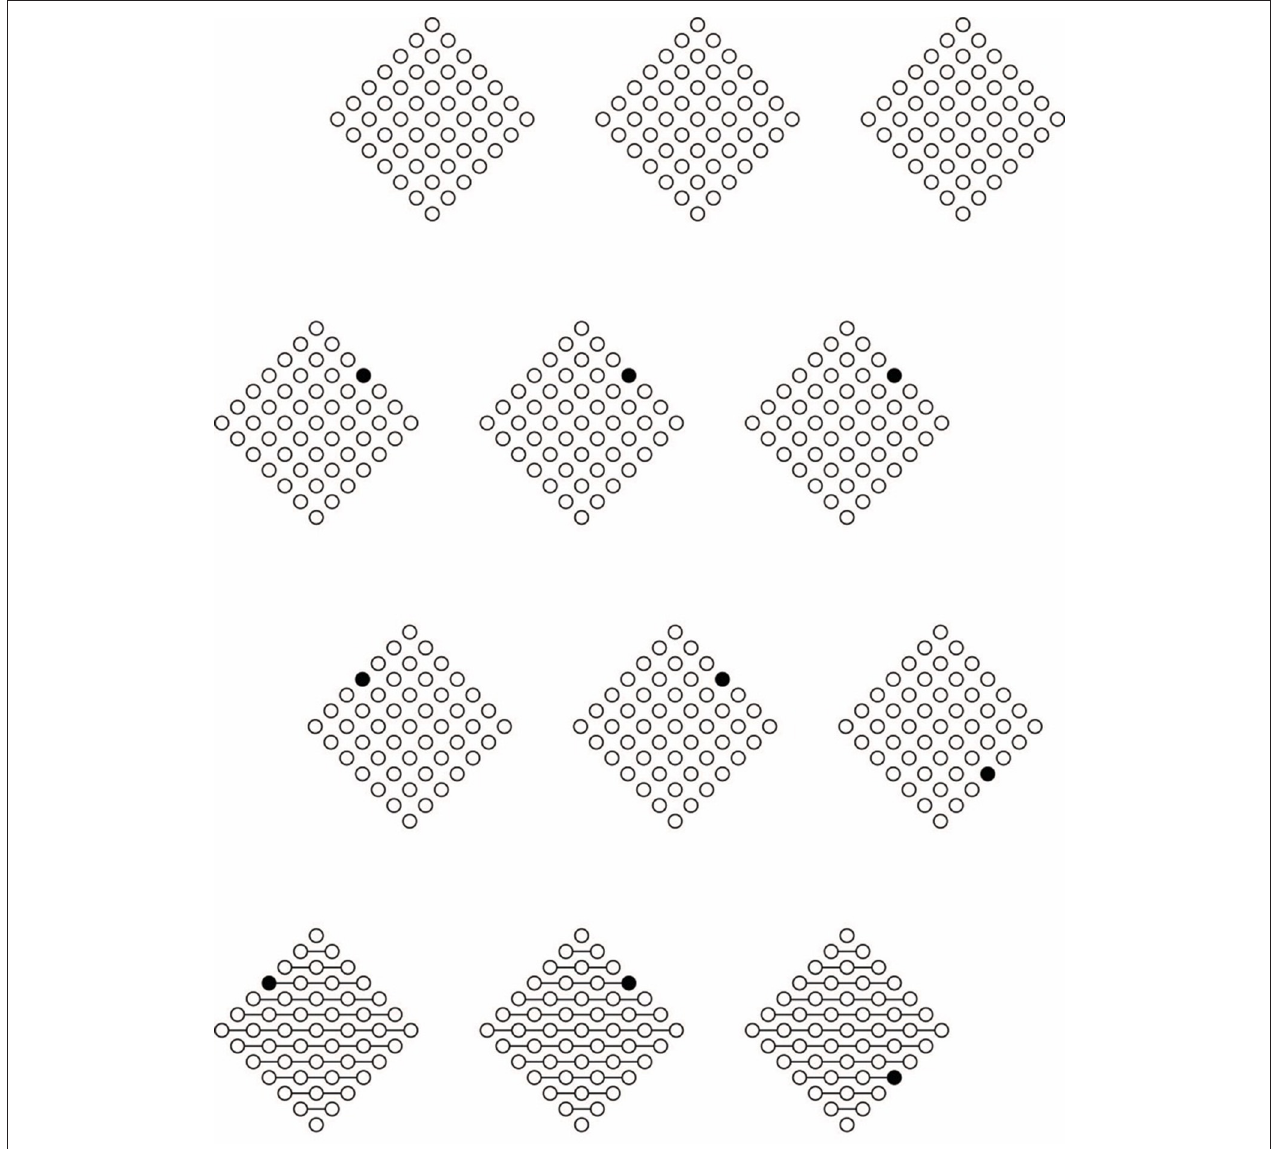
FIGURE 10 | Configural orientation effect (first row). Accentuation is pitted against configural orientation effect (second row). The patterns appear rotated in different directions according to the location of each accent (third row). Same outcome as (third row) when accentuation is pitted against the element connectedness principle (fourth